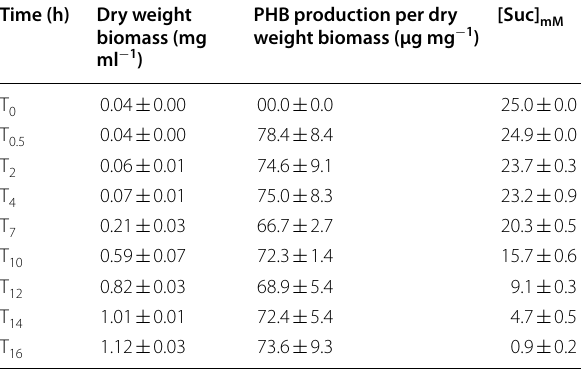
Table 1 Table showing dry weight biomass, PHB content and residual succinate concentration in the medium Time (h) Dry weight biomass